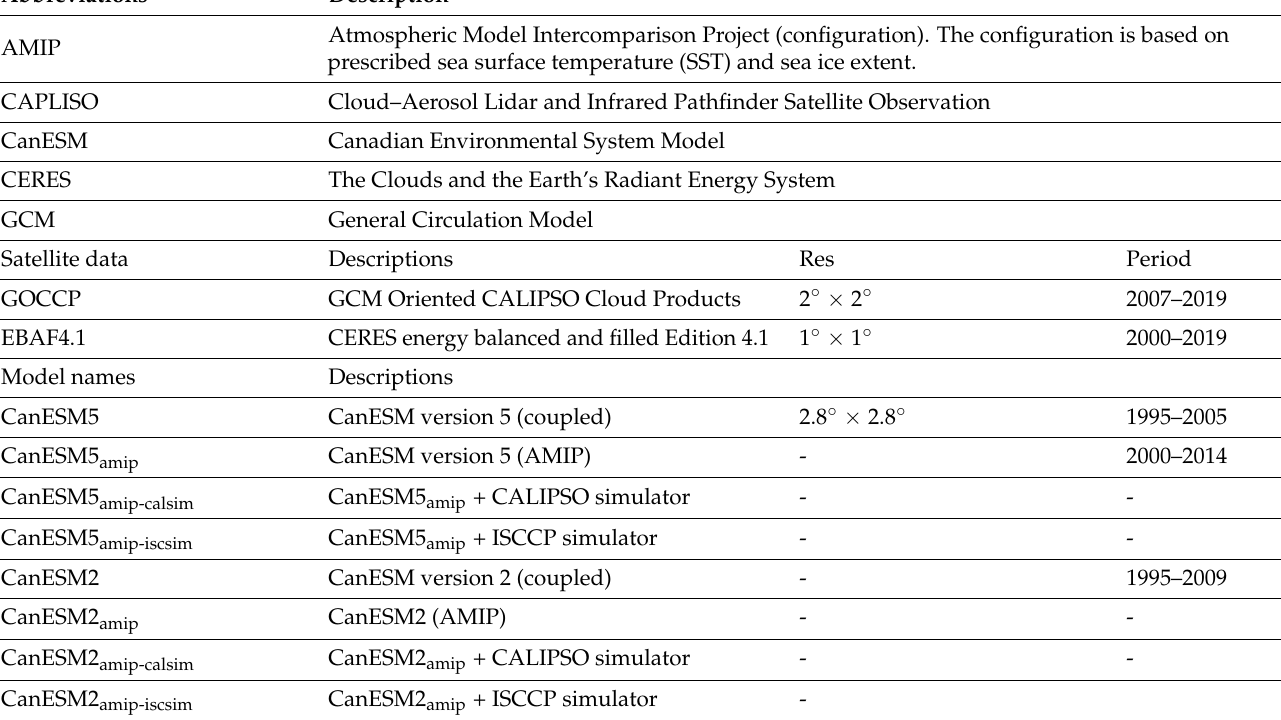
Table A1. The satellite cloud products, models, and abbreviations used in this